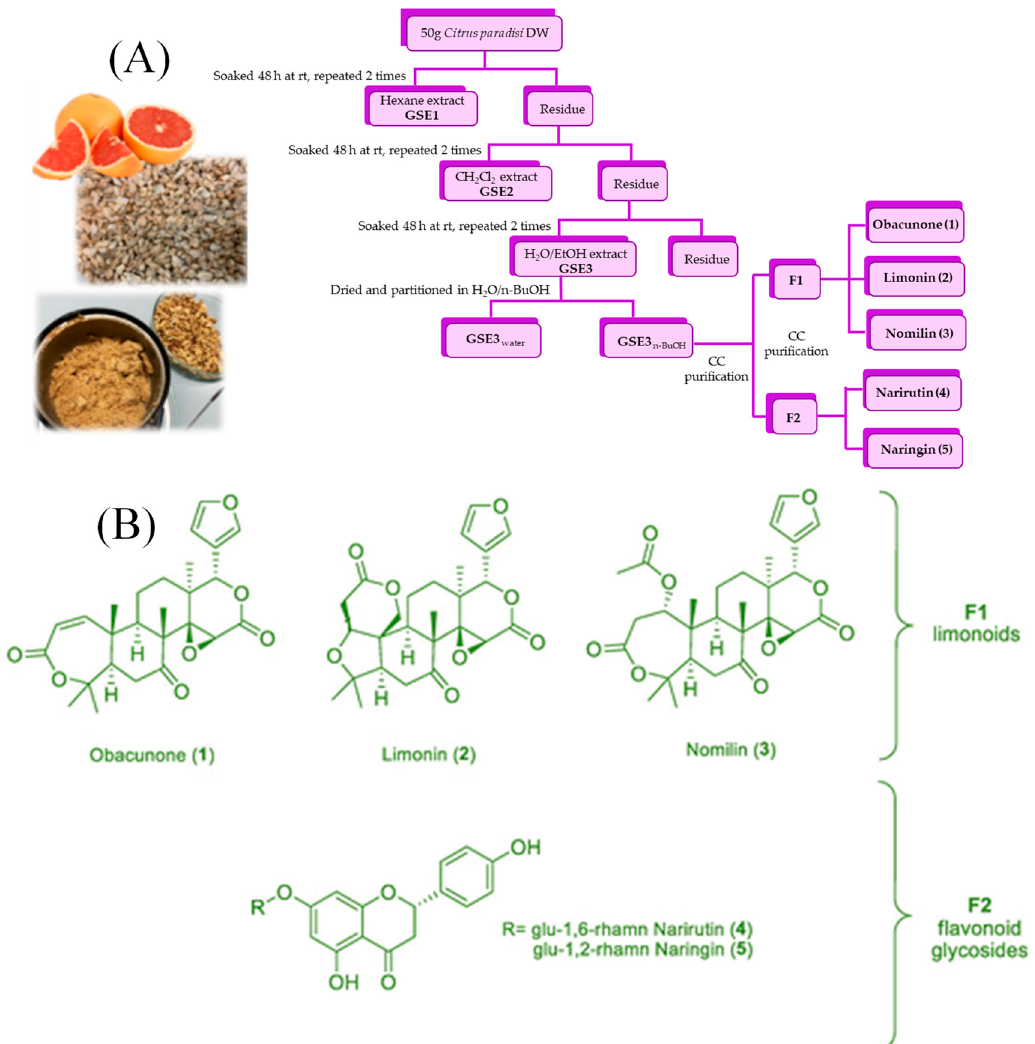
Figure 2. Extraction process of grapefruit seed extract ( A ), the structure of compounds extracted ( B ). (Adapted from Magurano et al., 2021) [46].